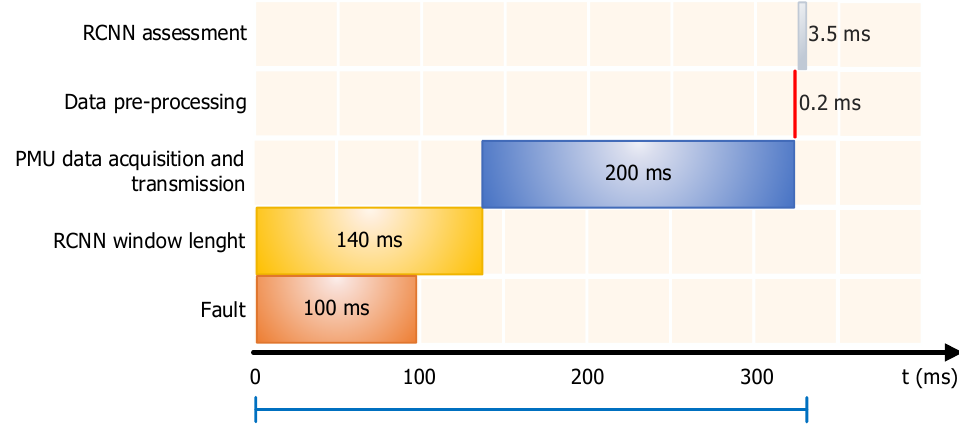
Figure 13. Time delay summary for RCNN real-time application.